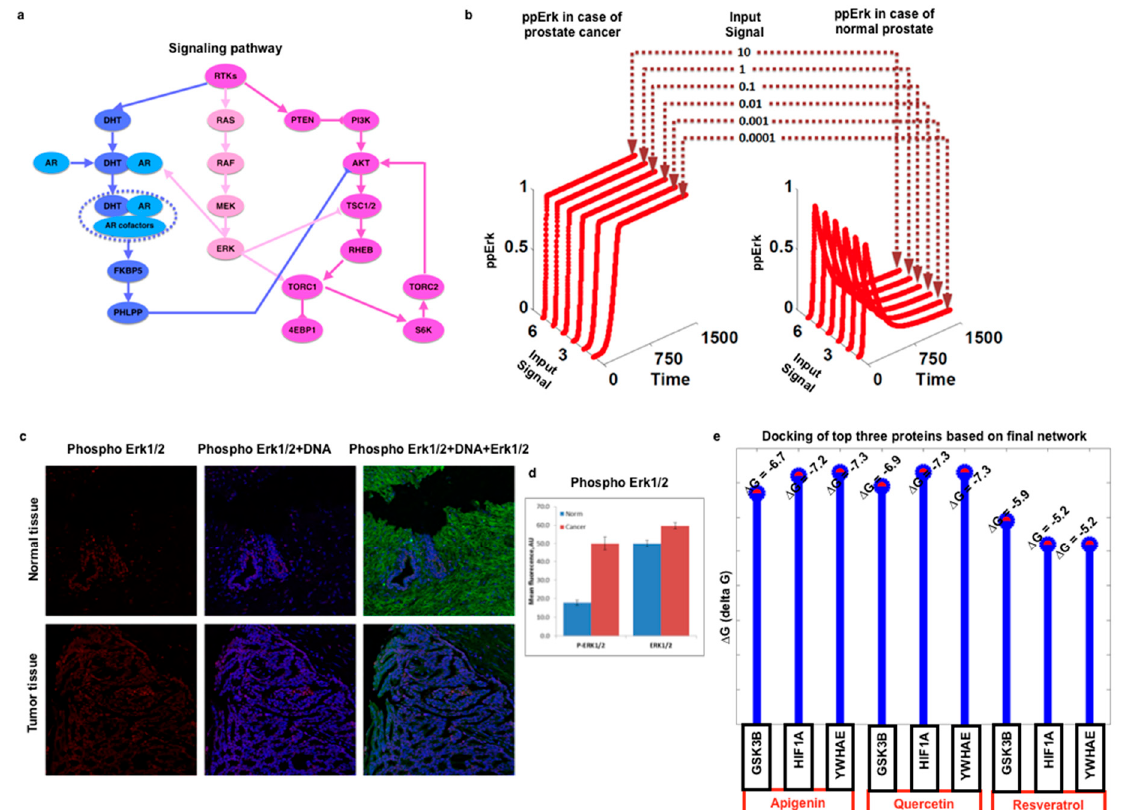
Figure 7. Systems-level application, validation, and integration of high-throughput data: ( a ) A sketch for AKT signaling pathway components in case of prostate cancer, ( b ) kinetics of ppERK calculated by using mass-action kinetics and ODE approach in case of normal and prostate cancer signaling, ( c ) the quantification for immunohistochemistry data, ( d ) ppERK expression in normal human and cancer prostate biopsies, and ( e ) delta G representing the herbal drugs’ interactions with GSK3B, HIF1A, and YWHAE, which appear highly dominant based on high-throughput databased crosstalk result.